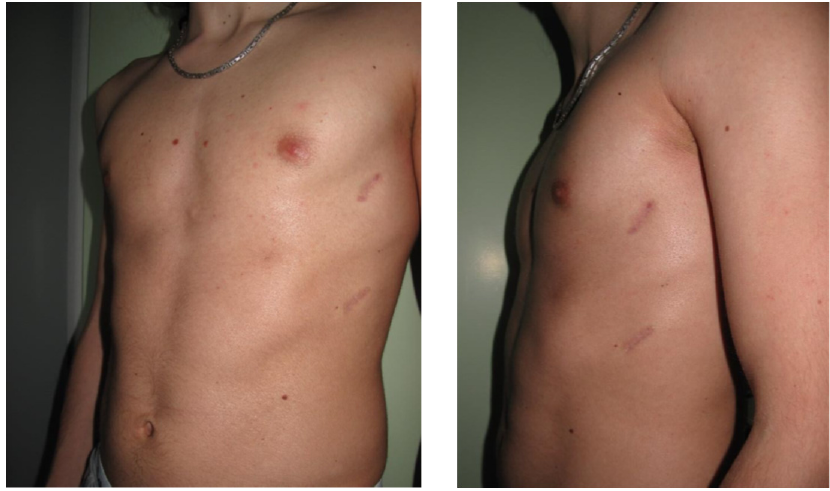
Figure 7. 17 years old male patient with PE and bilateral costal flaring, 1 year after